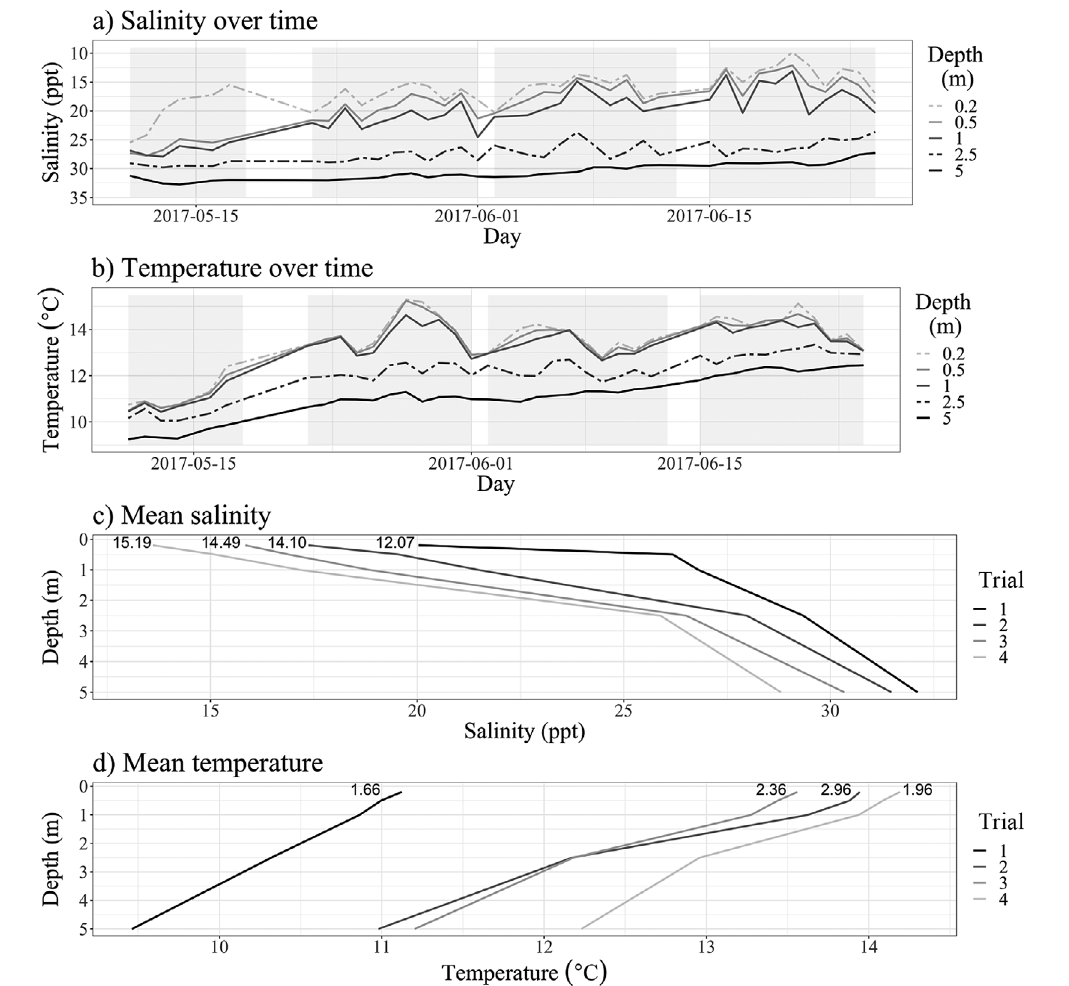
Fig. 1. Mean daily (a) salinity and (b) temperature at 0.2−5 m depth throughout the whole study period (10 May to 25 June 2017); and depth plotted against mean (c) salinity and (d) temperature for each of the 4 trials. Number at the top of the data line in (c) and (d) represents the range between the uppermost (0.2 m) and lowermost (5 m) sample depths for each trial. Shaded areas in (a) and (b) indicate the 4 trial